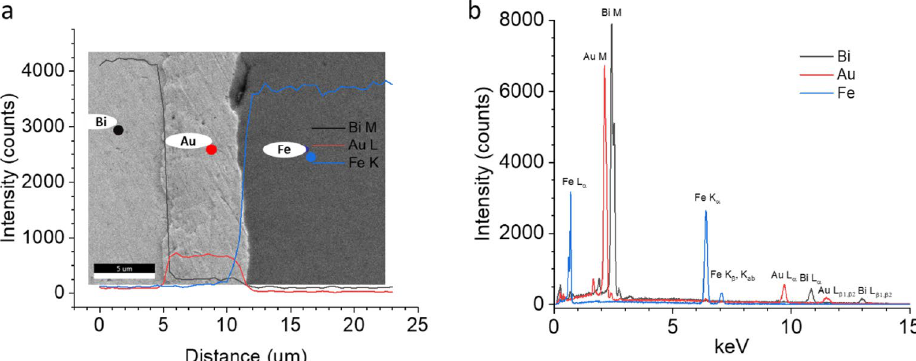
Figure 5. EDS of a bismuth-plated sample cross-section. ( a ) Linescan data across the cross-section from the bismuth M line (black), gold L line (red), and iron K line (blue). ( b ) Overlaid EDS spectra of bismuth (black), gold (red), and iron (blue) areas in the cross